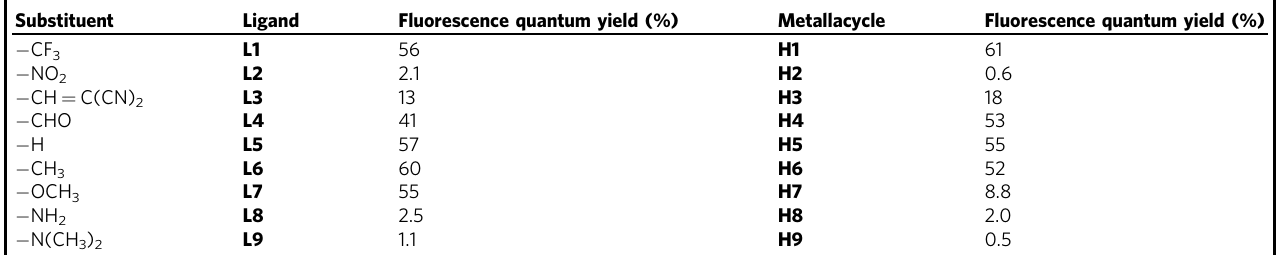
Table 1 Fluorescence quantum yields of ligands L1 – L9 and metallacycles H1 – H9 in DCM (5 μ M )